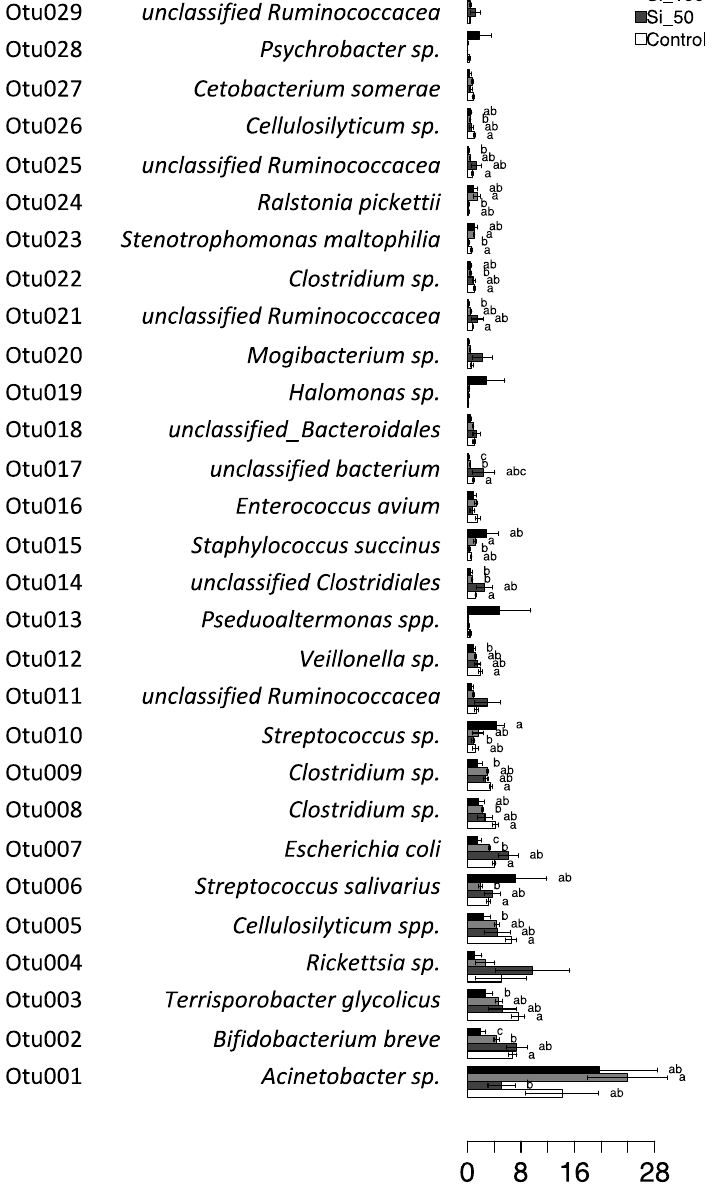
Figure 3. Metastats analysis testing significant between treatments. OTUs representing the 95% of total diversity are reported, and classified at the lowest taxonomical level, in most cases the species level. Treatments with the same letter are not significantly different according to Tukey’s